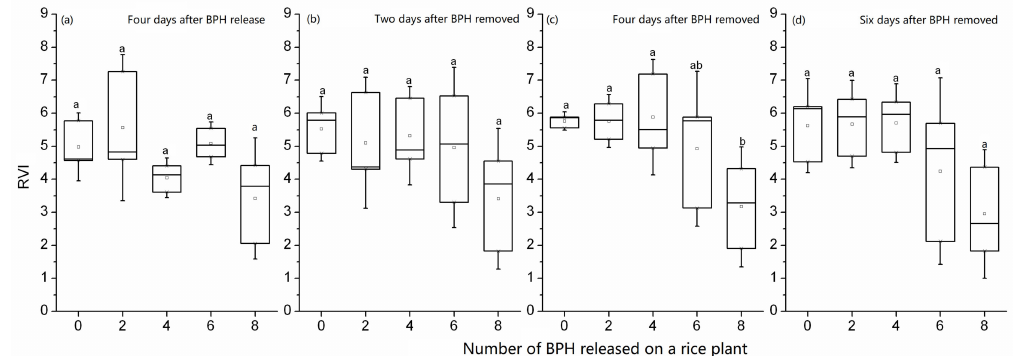
Figure 4. RVI 746/670 of rice leaves exposed to 0–8 second-instar BPH nymphs for four days ( a ) and 2–6 days after BPH exposure ( b , c and d ). In the box plot, the box represents the 25th and 75th percentiles; whiskers represent the minimum and maximum values; the line in box represents the median percentile; the open circle in a box represents the mean. The different letters above the box plots show significant differences in the RVI 746/670 means among different numbers of BPH at p = 0.05 level. When BPH nymphs damaged rice plants for 6 days, the RVI 746/670 of rice plants decreased ( F 4, 10 = 3.35, p = 0.055, Figure